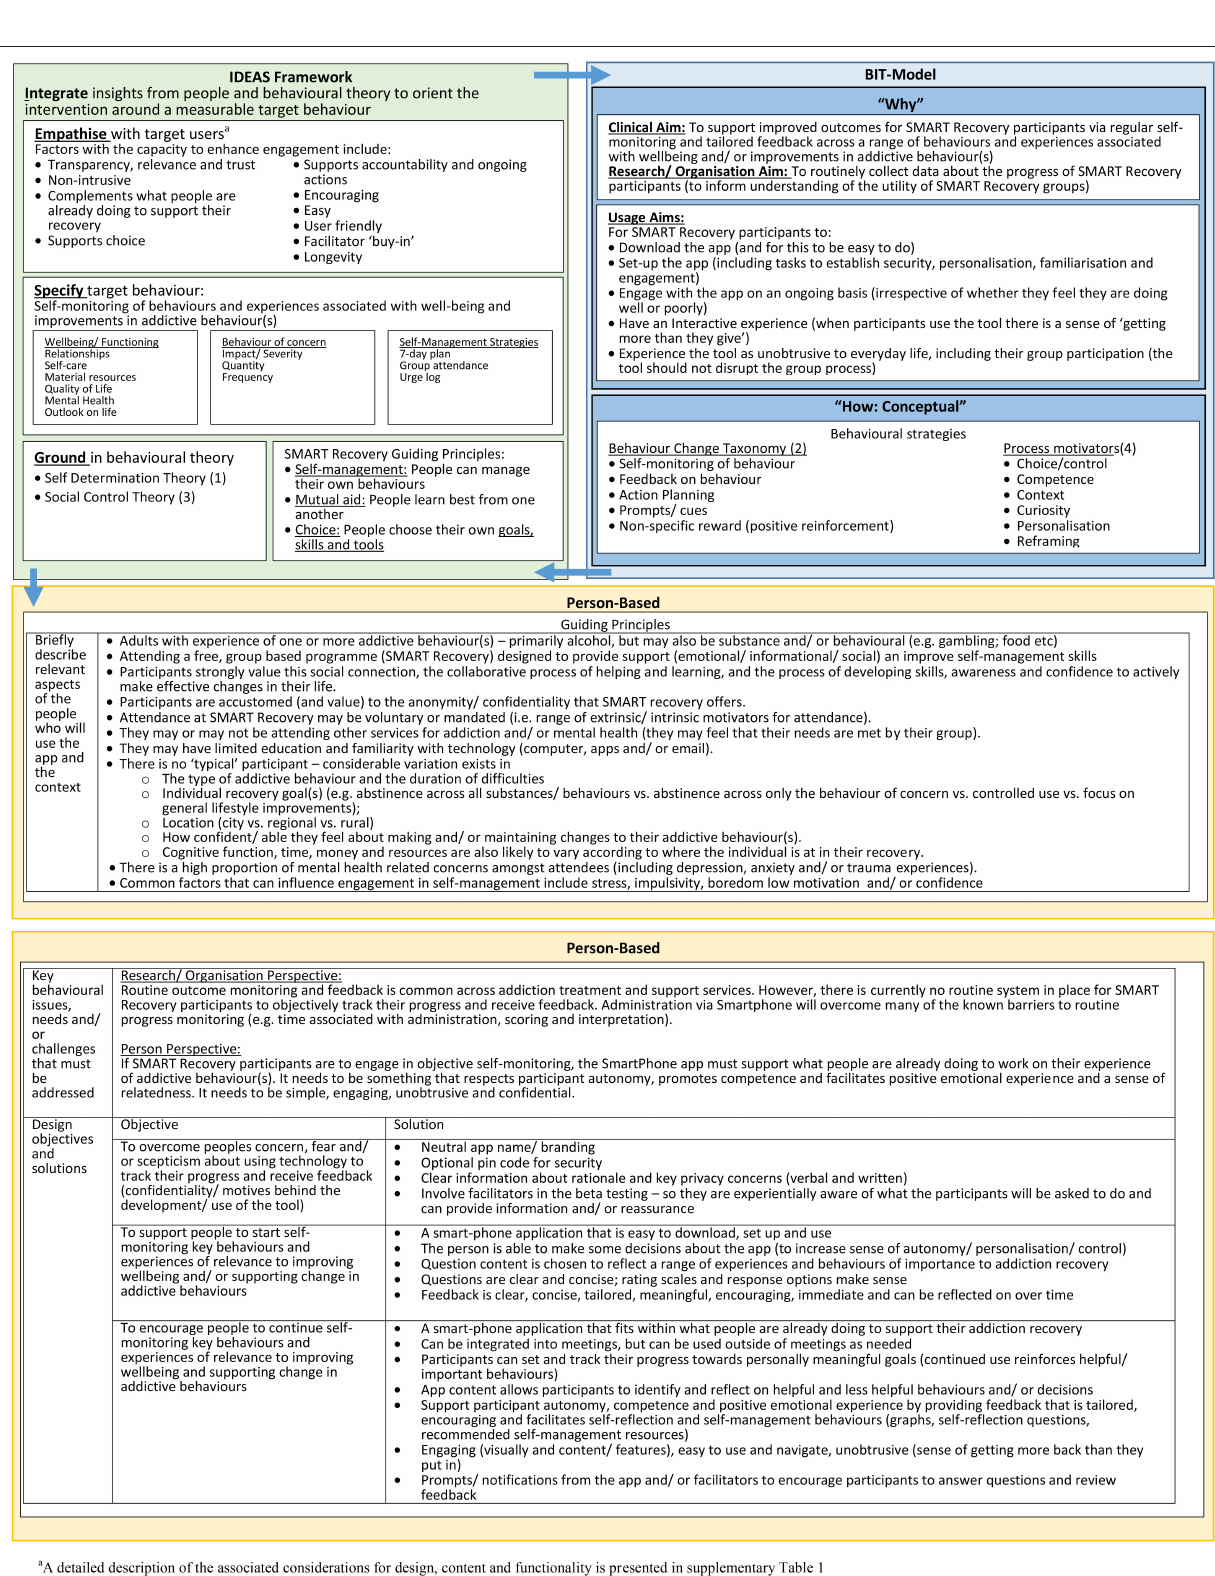
Frontiers in Psychiatry |